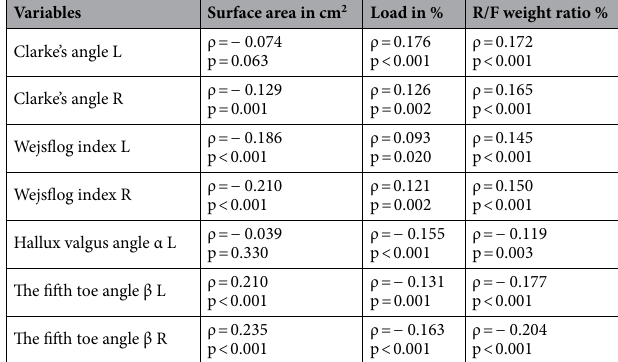
Table 4. Associations between the hindfoot load and morphological features of the